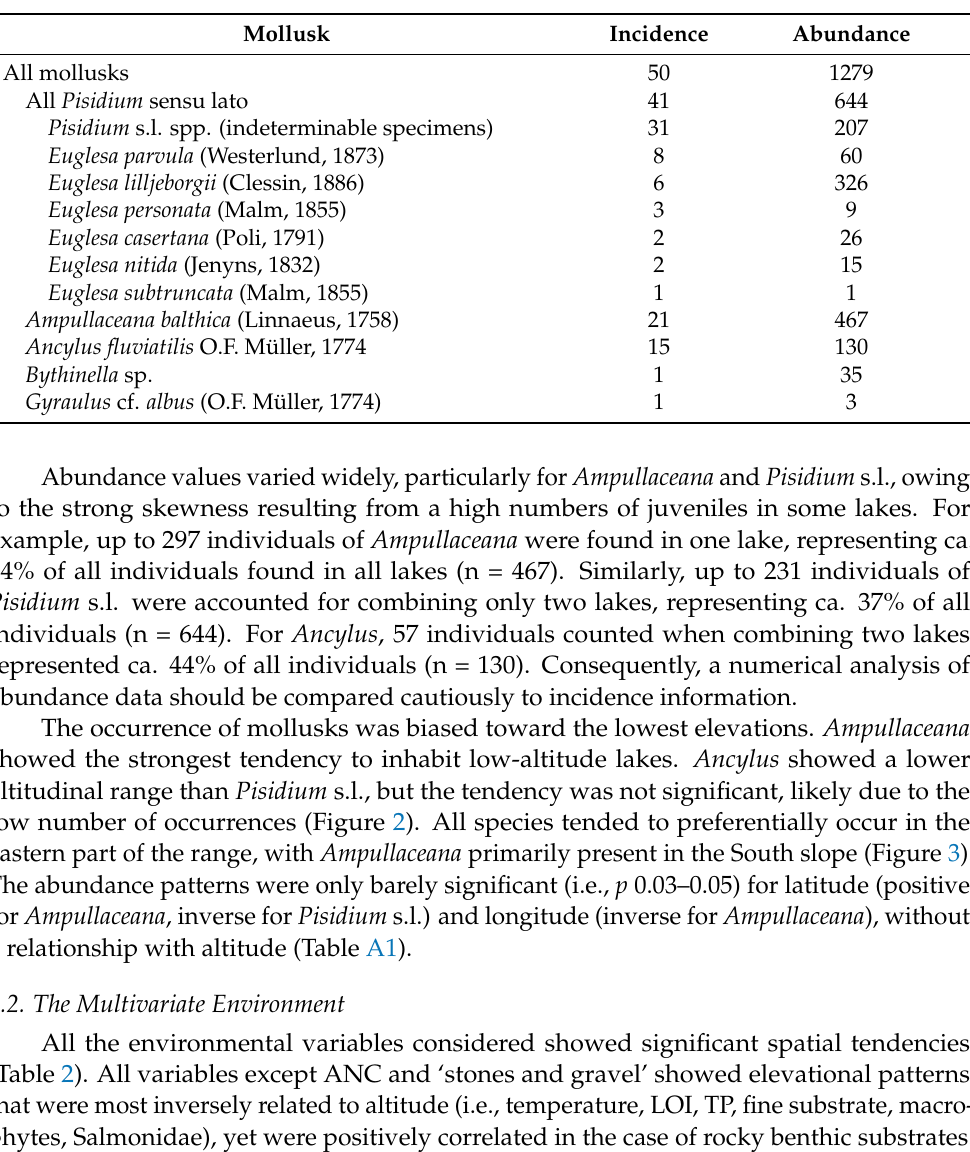
Table 1. Mollusks found in terms of incidence (number of lake occurrences) and abundance (total number of individuals